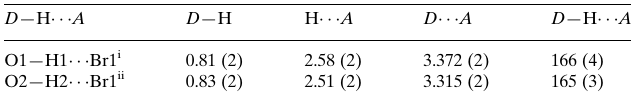
Hydrogen-bond geometry (A˚ , (cid:4)